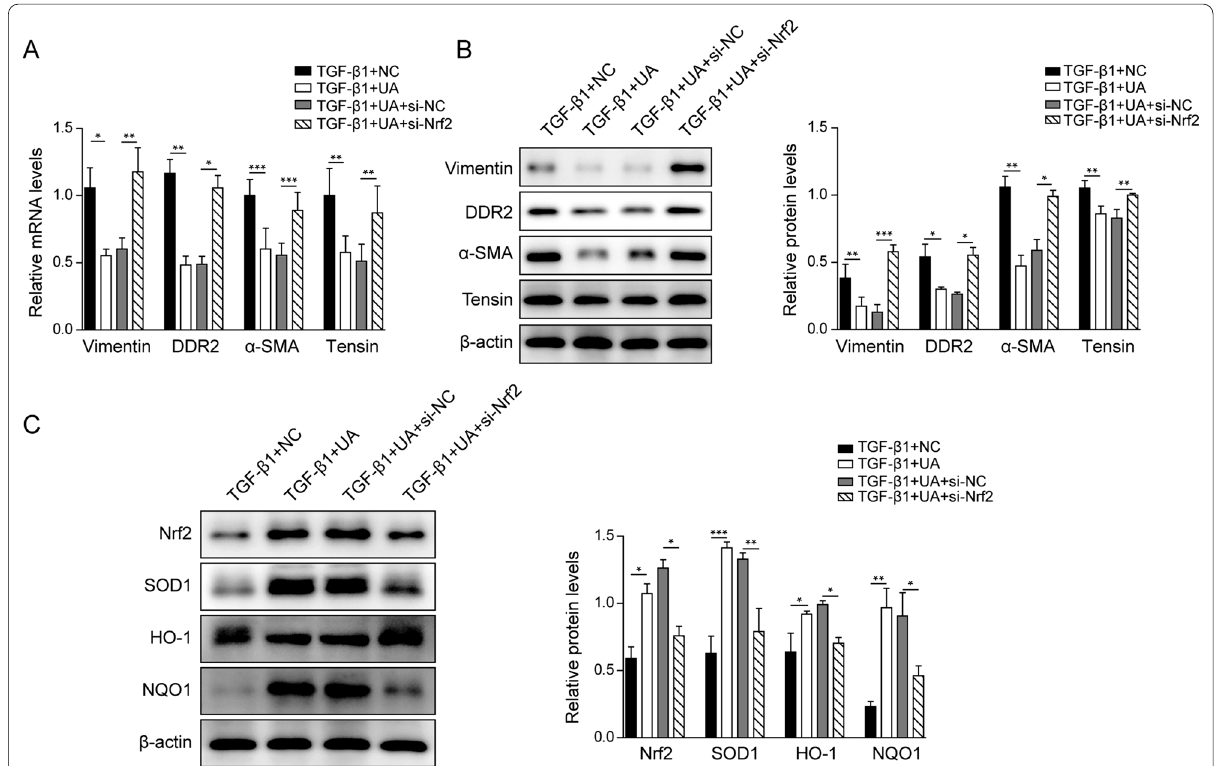
Fig. 4 Nrf2 pathway was responsible for UA-induced repression of CMT process in CFs with TGF-β1 treatment. A The mRNA level and B the protein level of fibrosis markers including vimentin, DDR2, tensin and α-SMA in CFs after indicated treatments. C The protein levels of Nrf2, SOD1, HO-1 and NQO1 in CFs after indicated treatments. β-actin was used as normalized control. NC: negative control. N